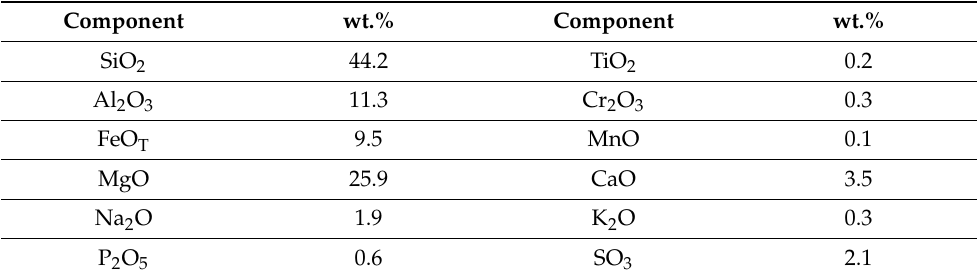
Table 2. Bulk major element chemistry of JEZ-1 (XRF results from Exolith Lab).